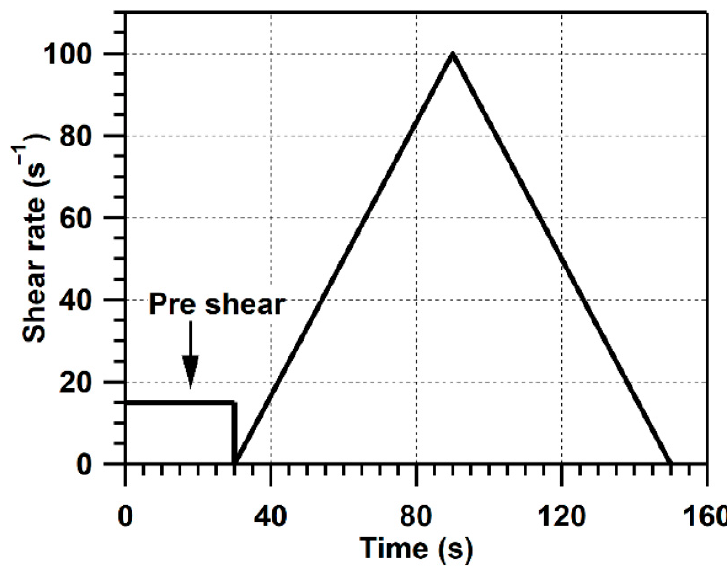
paste for rheology test is shown in Figure 5.